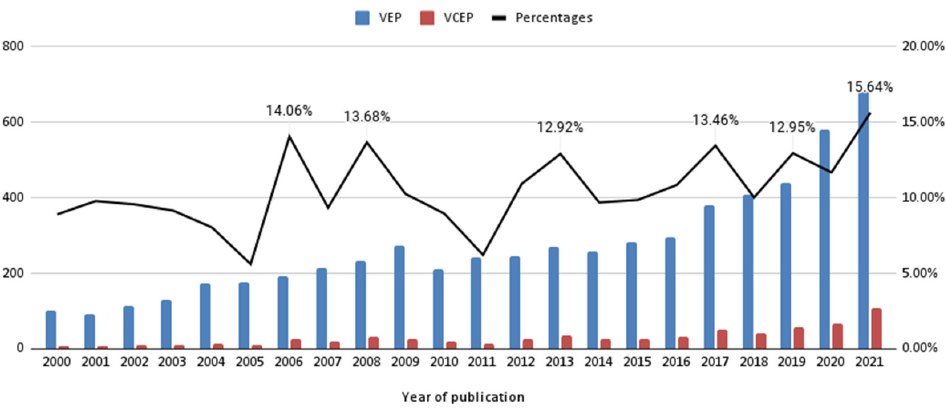
Figure 1. Yearly numbers of veterinary education publications (VEPs), veterinary communication education publications (VCEPs), and the percentages of VCEPs/VEPs (2000 to 2021).